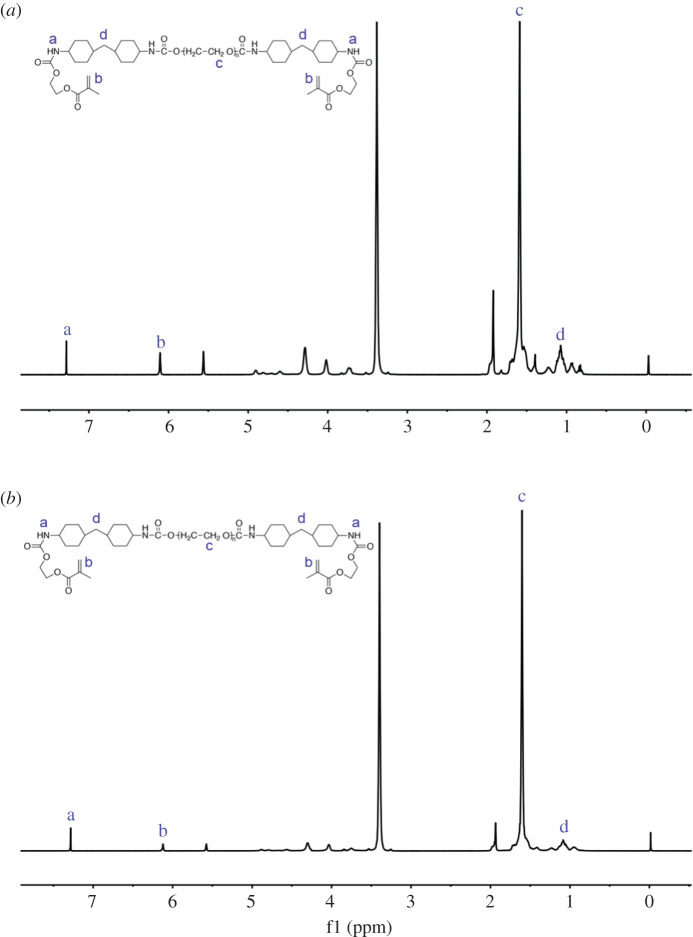
(a) 1H NMR spectra of PUA. (b) 1H NMR spectra of PUB.